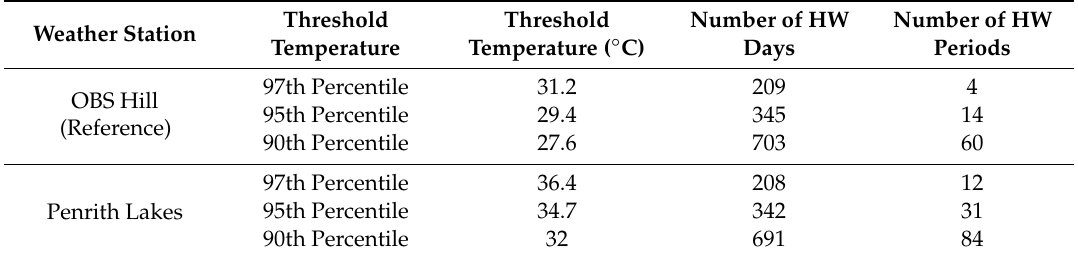
Table 1. Number of Heatwave (HW) days and periods at Penrith Lakes and Observatory (OBS) Hill (1999–2017).